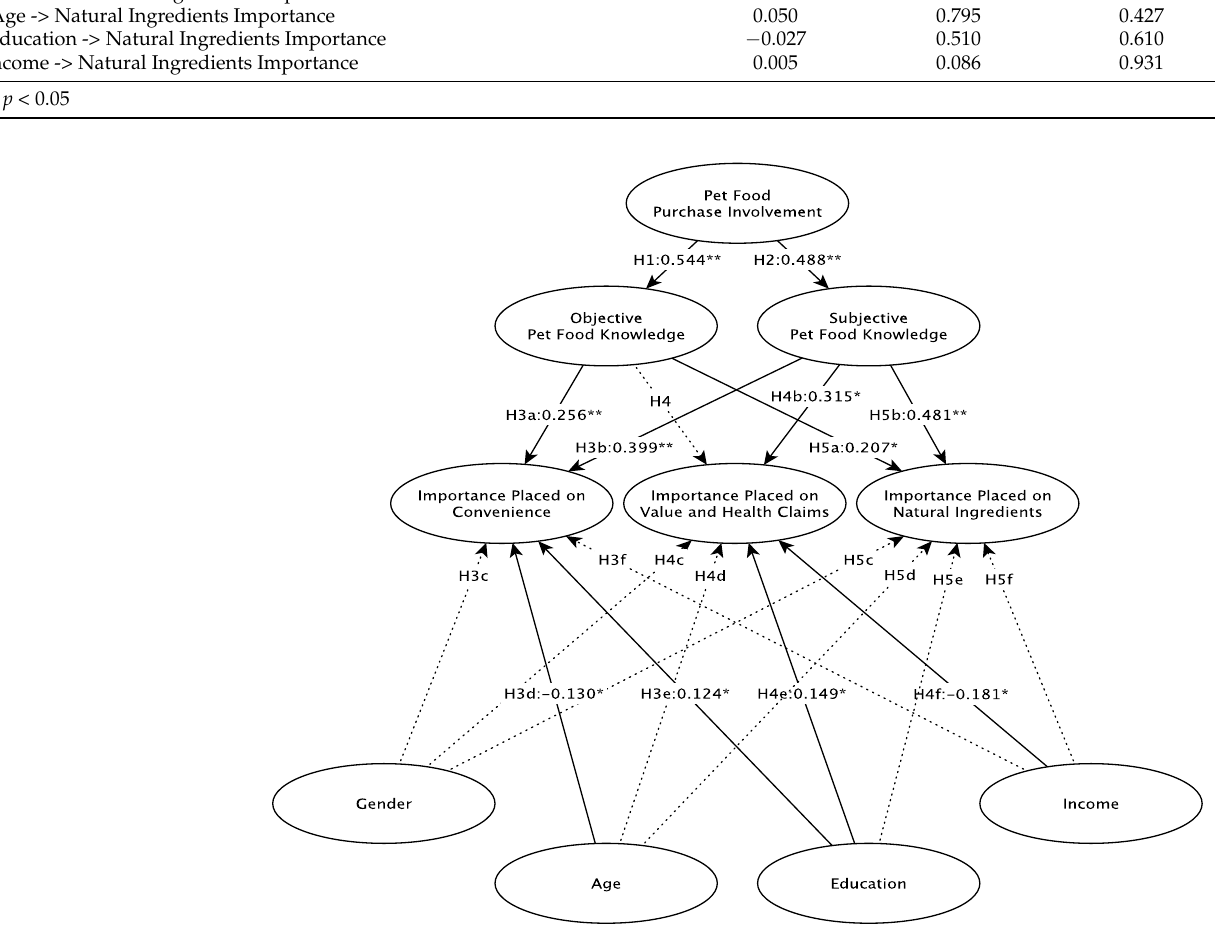
Figure 2. Conceptual Model Results, * = p < 0.05, ** p < 0.01, dotted line = not significant.